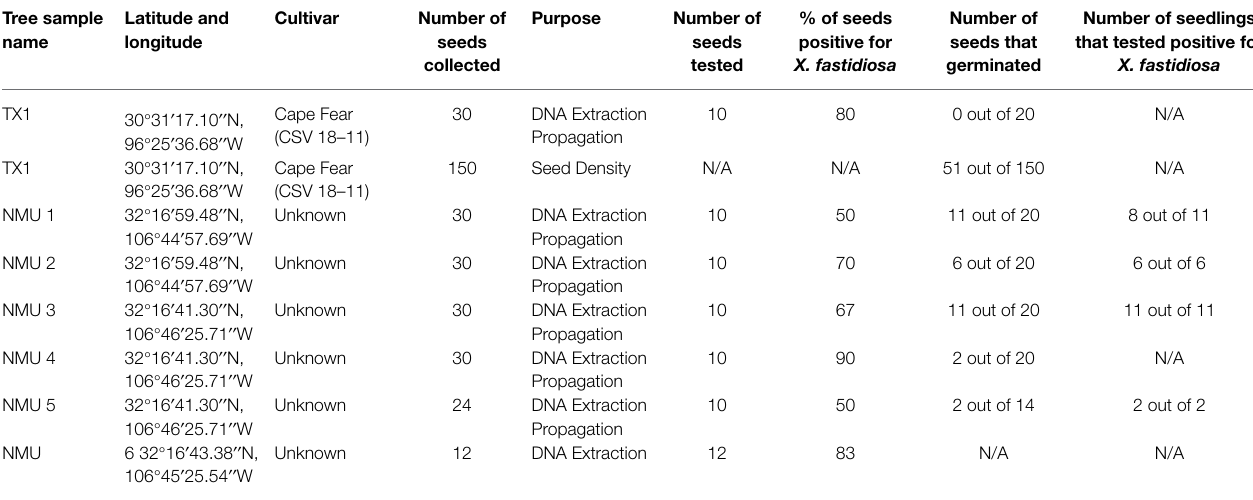
TABLE 1 | Seed collection, germination, and diagnoses. Tree sample